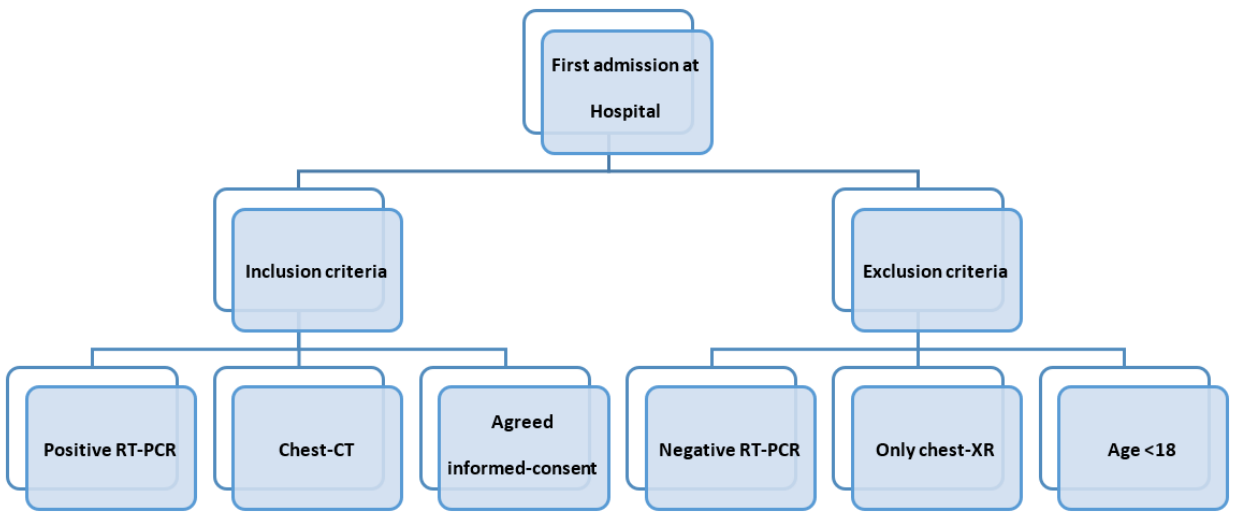
Figure 1. Flow chart: inclusion and exclusion